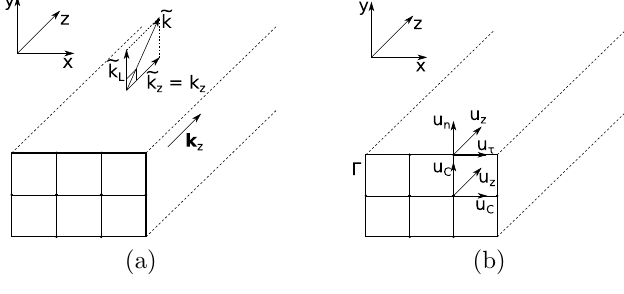
Figure 2. (a) Wavenumbers at interface of waveguide and fluid; (b) schematic classification of nodal displacements in the